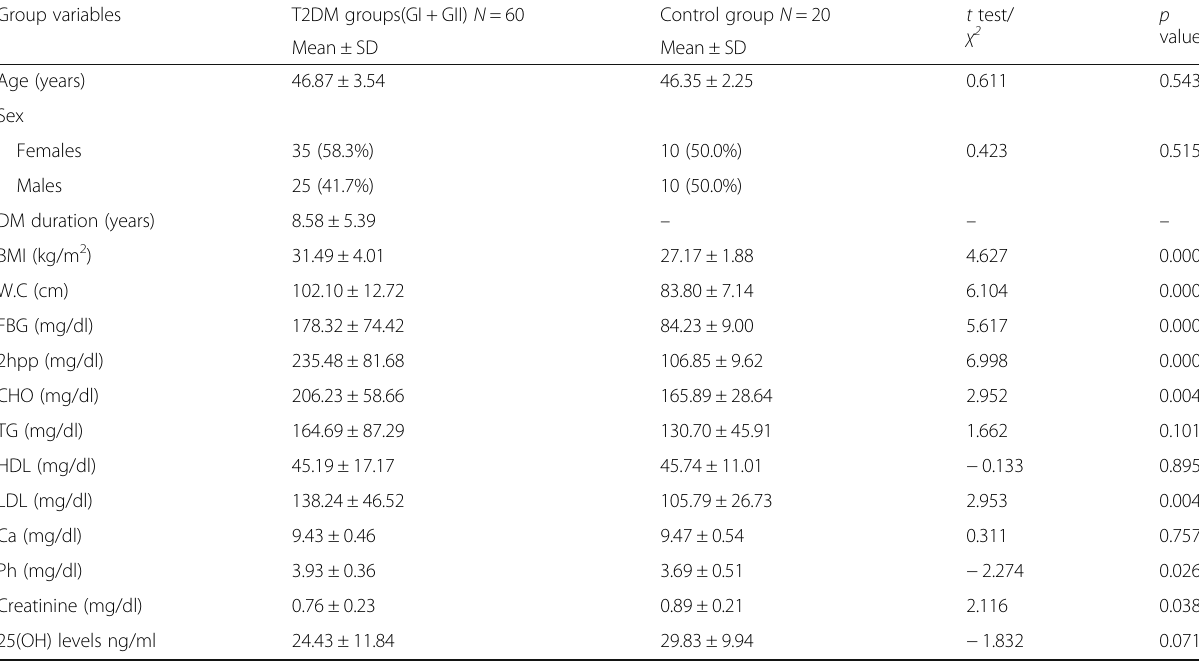
Table 1 Demographic and laboratory characteristics of T2DM groups (G Ι + GII) and control group Group